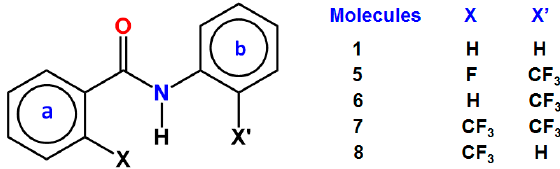
Figure 8. Chemical structure of benzanilide ( 1 ) and its trifluoromethyl derivatives 5 – 8 .